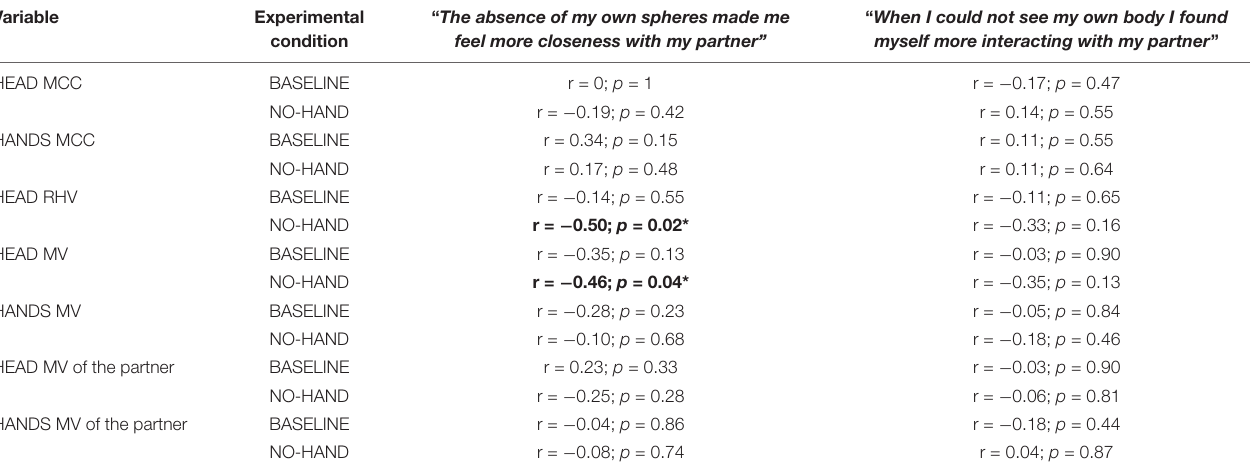
TABLE 2 | Spearman rank correlation between experiential reports and kinematic variables. Variable Experimental